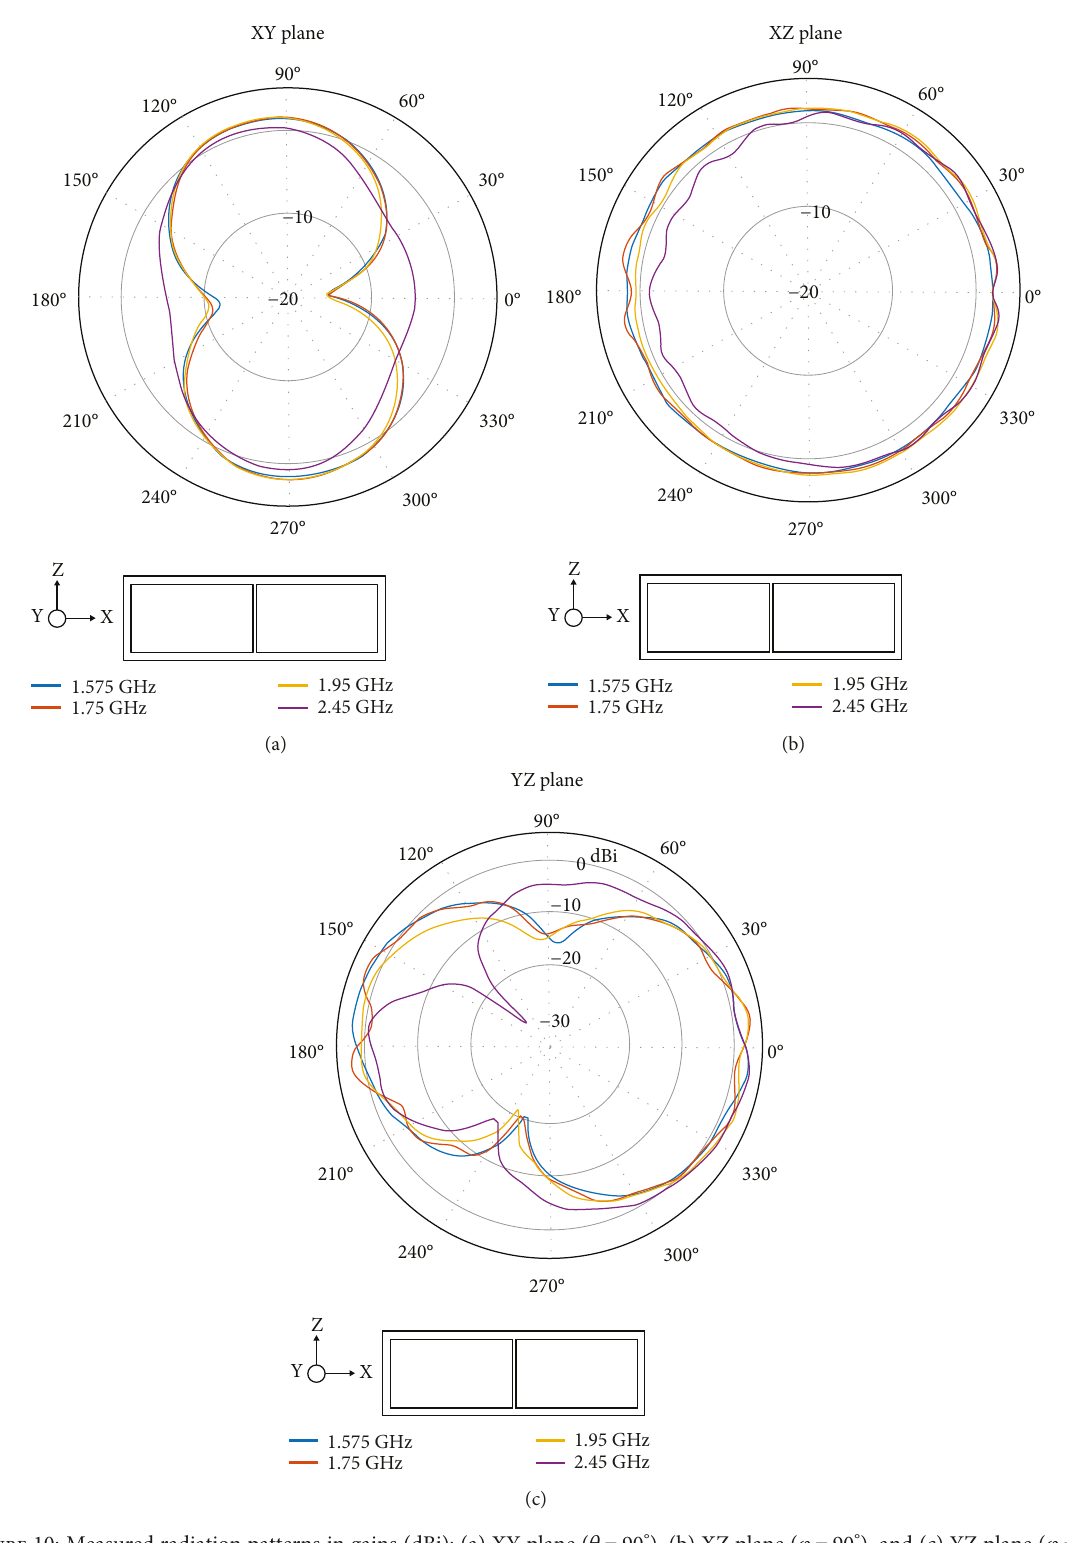
Figure 10: Measured radiation patterns in gains (dBi): (a) XY plane ( θ = 90 ° ), (b) XZ plane ( φ = 90 ° ), and (c) YZ plane ( φ = 0 °